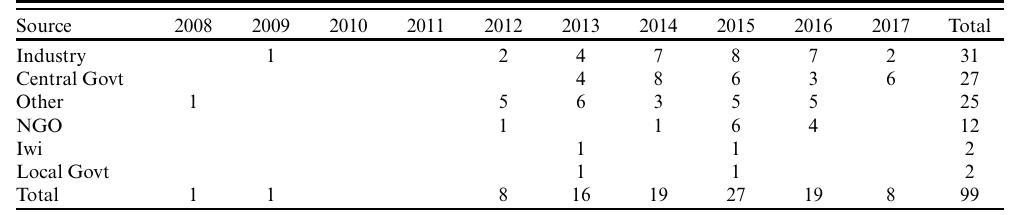
Table 1 . Number of documents related to New Zealand’s marine industries that mention social license to operate (SLO) by source, 2008–2017.